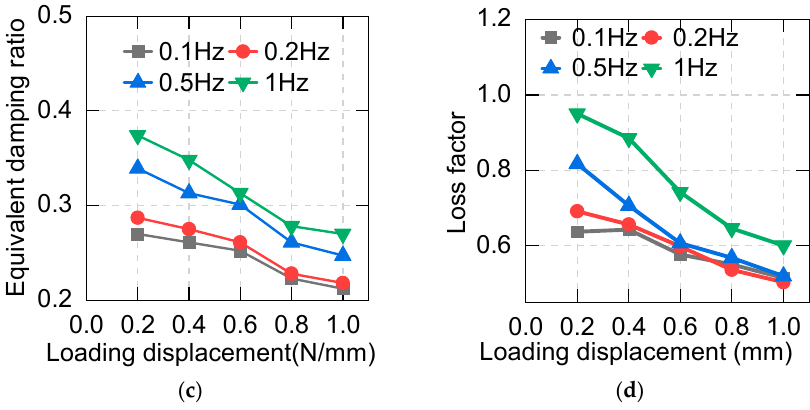
Figure 7. Dependence of the damping properties of asphalt on loading displacement: ( a ) equivalent stiffness; ( b ) storage stiffness; ( c ) equivalent damping ratio; ( d ) loss factor.